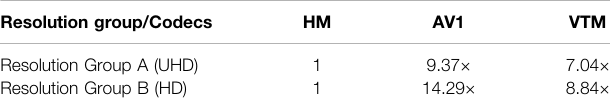
TABLE 8 | Computational complexity comparison.